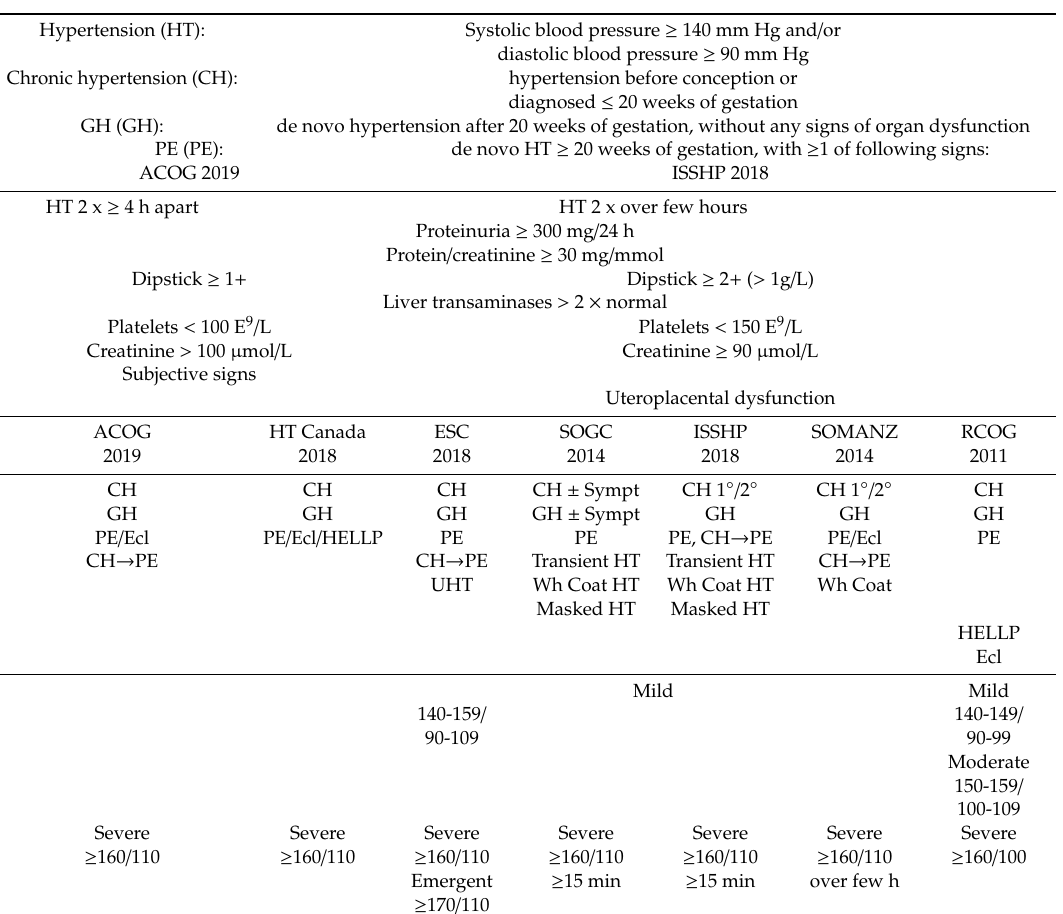
Table 1. Criteria for the diagnosis of preeclampsia, as defined by the American College of Obstetrics and Gynecology (ACOG) and by the International Society for Studies of Hypertension in Pregnancy (ISSHP), with further specifications used by ACOG, Hypertension Canada (HT Canada), European Society of Cardiology (ESC), Society of Obstetricians and Gynaecologists of Canada (SOGC), ISSHP, Society of Obstetric Medicine of Australia and New Zealand (SOMANZ), and the Royal College of Obstetricians and Gynaecologist (RCOG [2–4]).